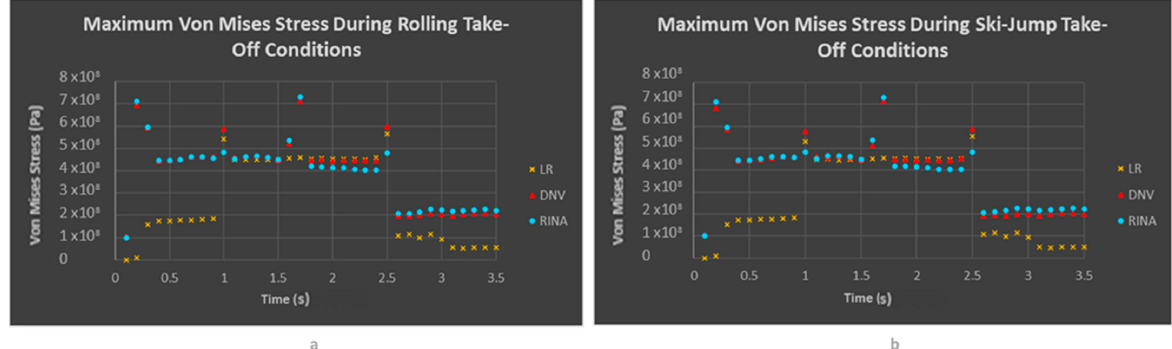
Figure 13. Maximum deflection of the deck plate under the take-off condition; ( a ) dynamic take-off and ( b ) ski-jump.